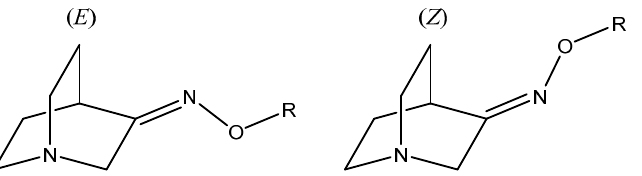
Figure 1. ( E ) and ( Z ) stereoisomers of O -substituted quinuclidin-3-one oximes.